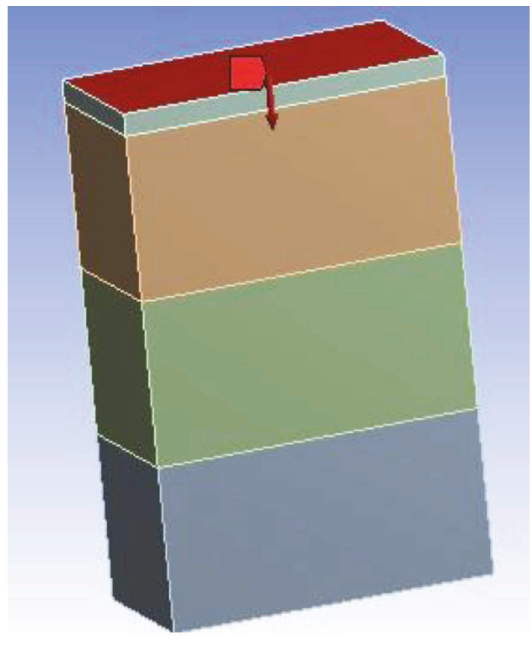
Figure 1: FEM model of CSRE prism (H/T � 3) under concentric